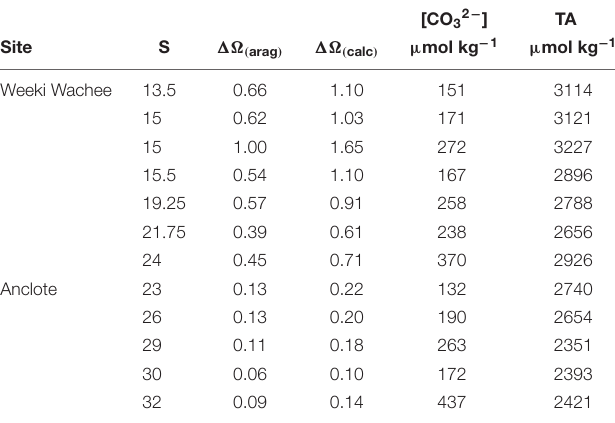
TABLE 2 | The salinity, (cid:49)(cid:127) ( aragonite ) , (cid:49)(cid:127) ( calcite ) , carbonate ion concentration and total alkalinity for sampling sites in the mixing zones of the Anclote and Weeki Wachee Rivers in central-west